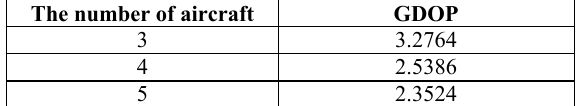
Table 2. The relationship between the number of aircraft and GDOP.